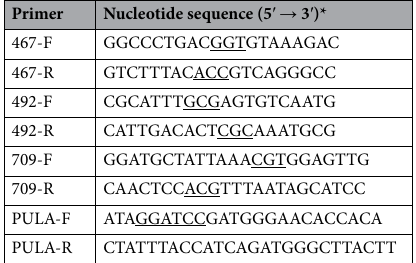
Table 1. Primers used for site-directed mutagenesis of PulA. *Underlined nucleotide sequence encoded a mutated amino